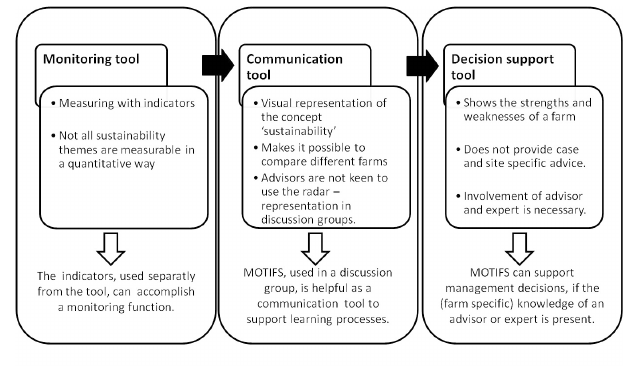
Fig. 3 . Evolution in MOTIFS’ functions (in the white boxes: pros and cons per function; under the white boxes: the way MOTIFS can be used for each